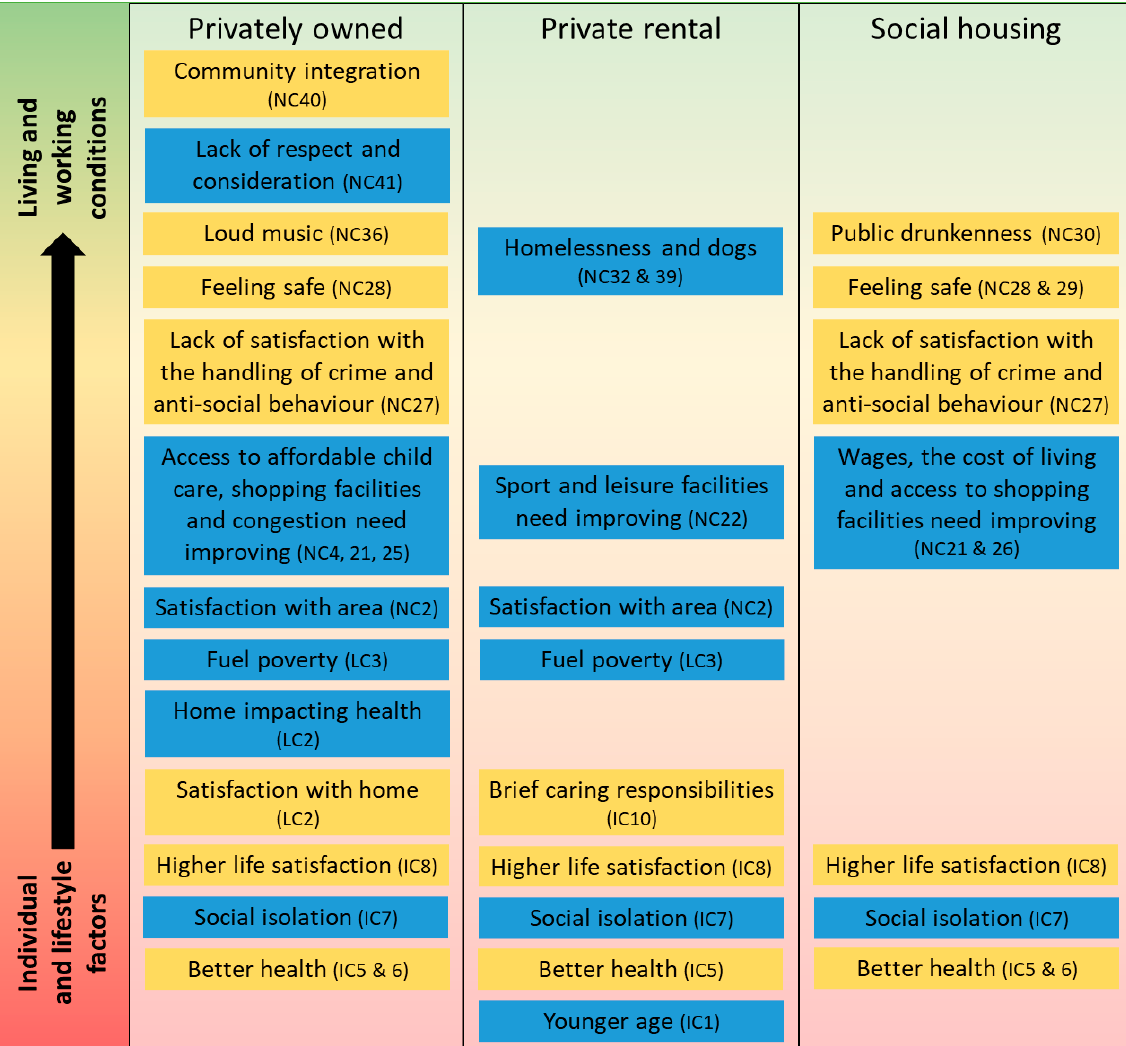
Figure 2. Individual, living, and neighbourhood circumstances contributing to mental wellbeing among homeowners, private renters, and social housing residents. Factors in yellow were associated with better mental wellbeing, while those in blue were associated with worse mental wellbeing.